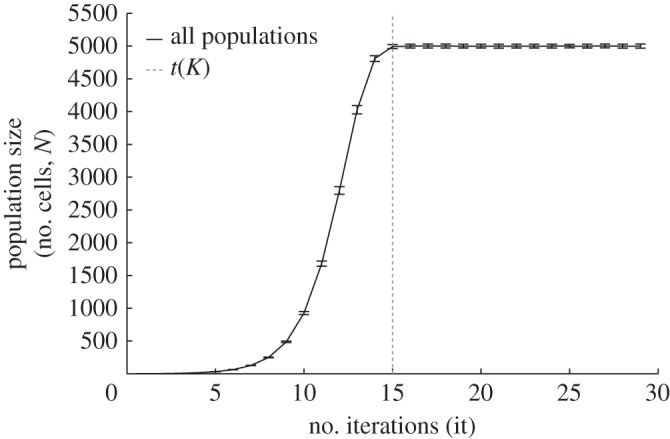
Growth rate across populations in one and two dimensions. The plot shows the mean and standard deviation of the growth curve of all the populations studied: five different turnovers (0.9, 0.5, 0.1, 0.01, 0.001) in both one- and two-dimensional simulations (100 samples each). The dashed line indicates the number of iterations t(K) at which the carrying capacity is reached. Although each scenario has different birth and death rates and morphology, all populations reach their carrying capacity at the same time, indicating the same growth rate.